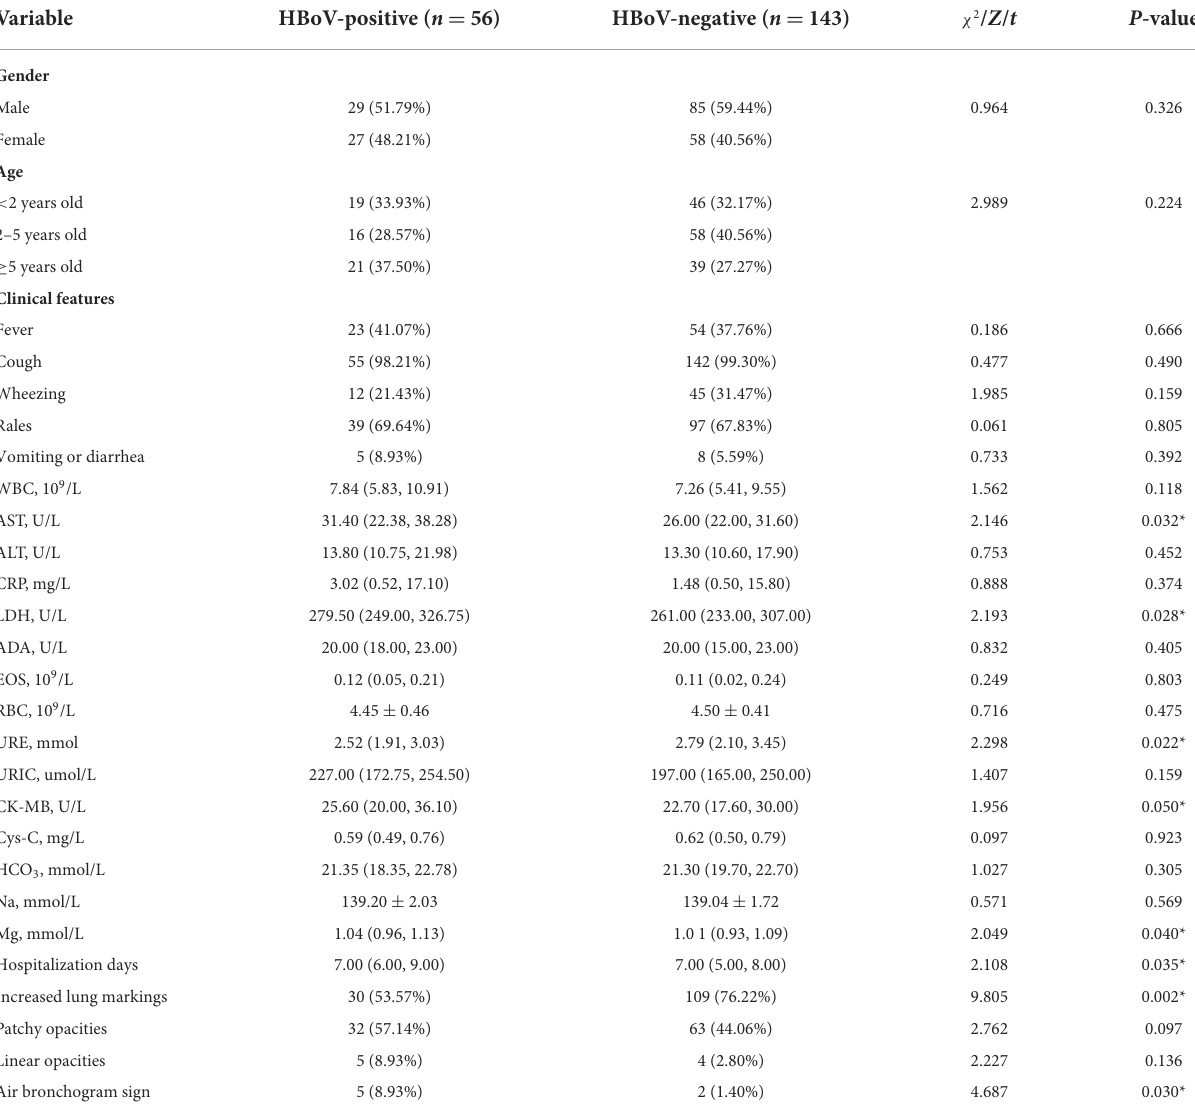
TABLE 4 Clinical characteristics of ARI patients with or without